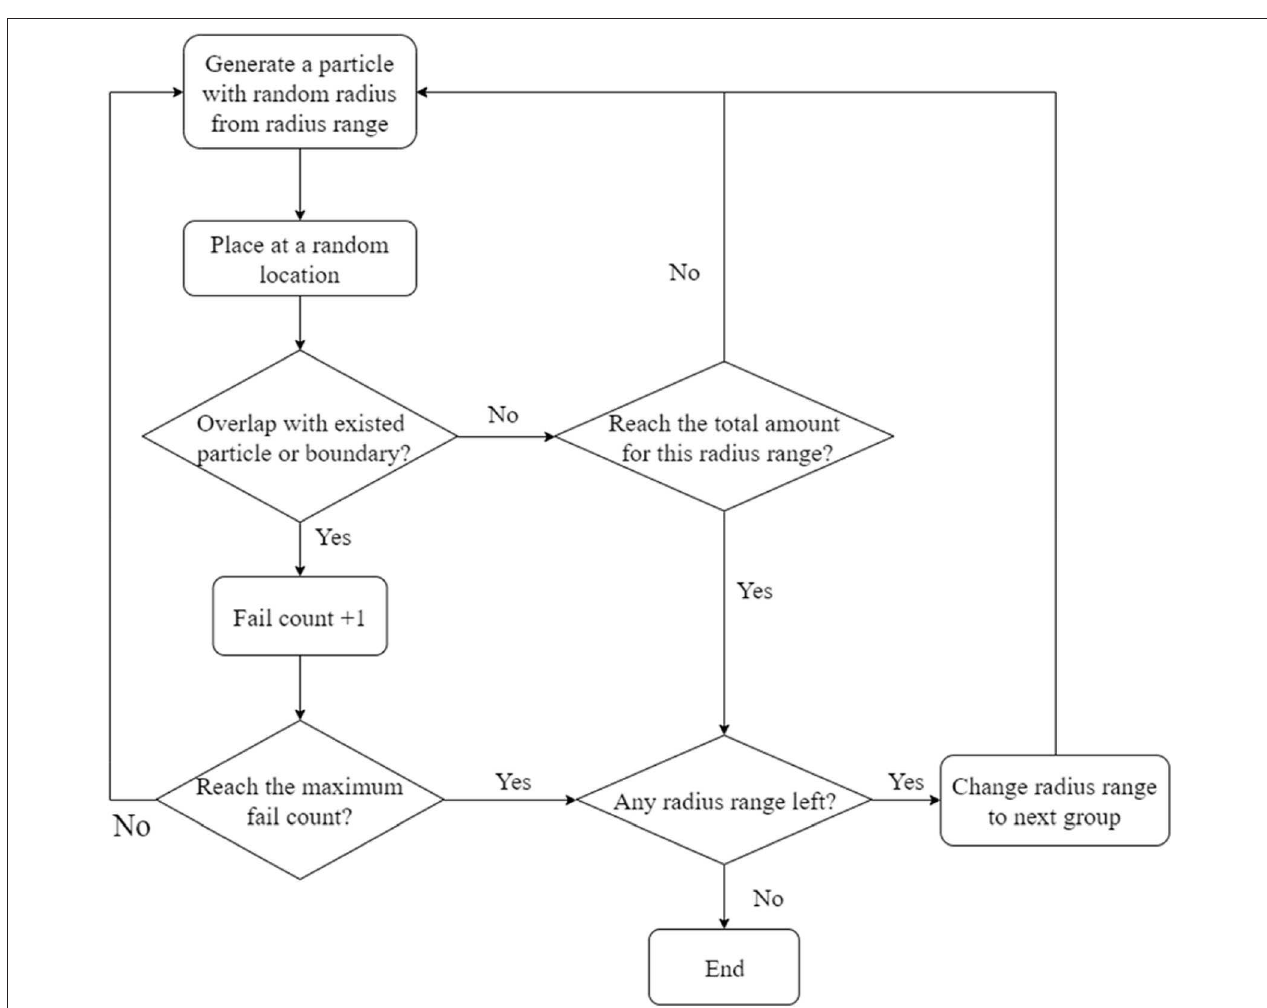
FIGURE 1 | Flow chart of aggregate